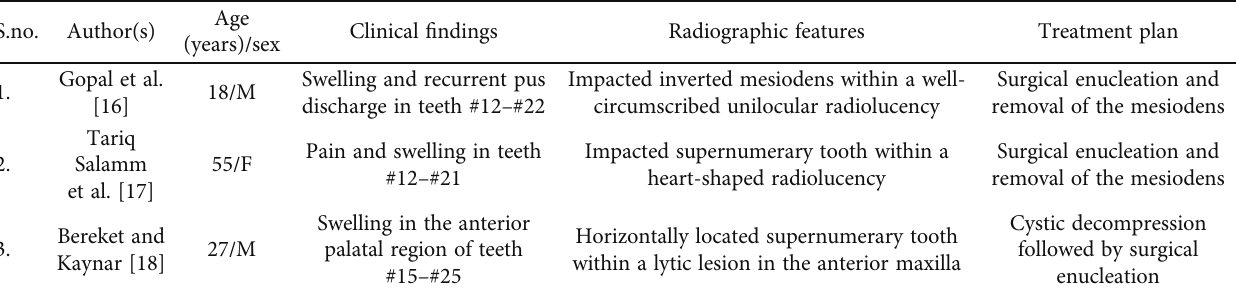
Table 1: Reported NPDC cases with impacted